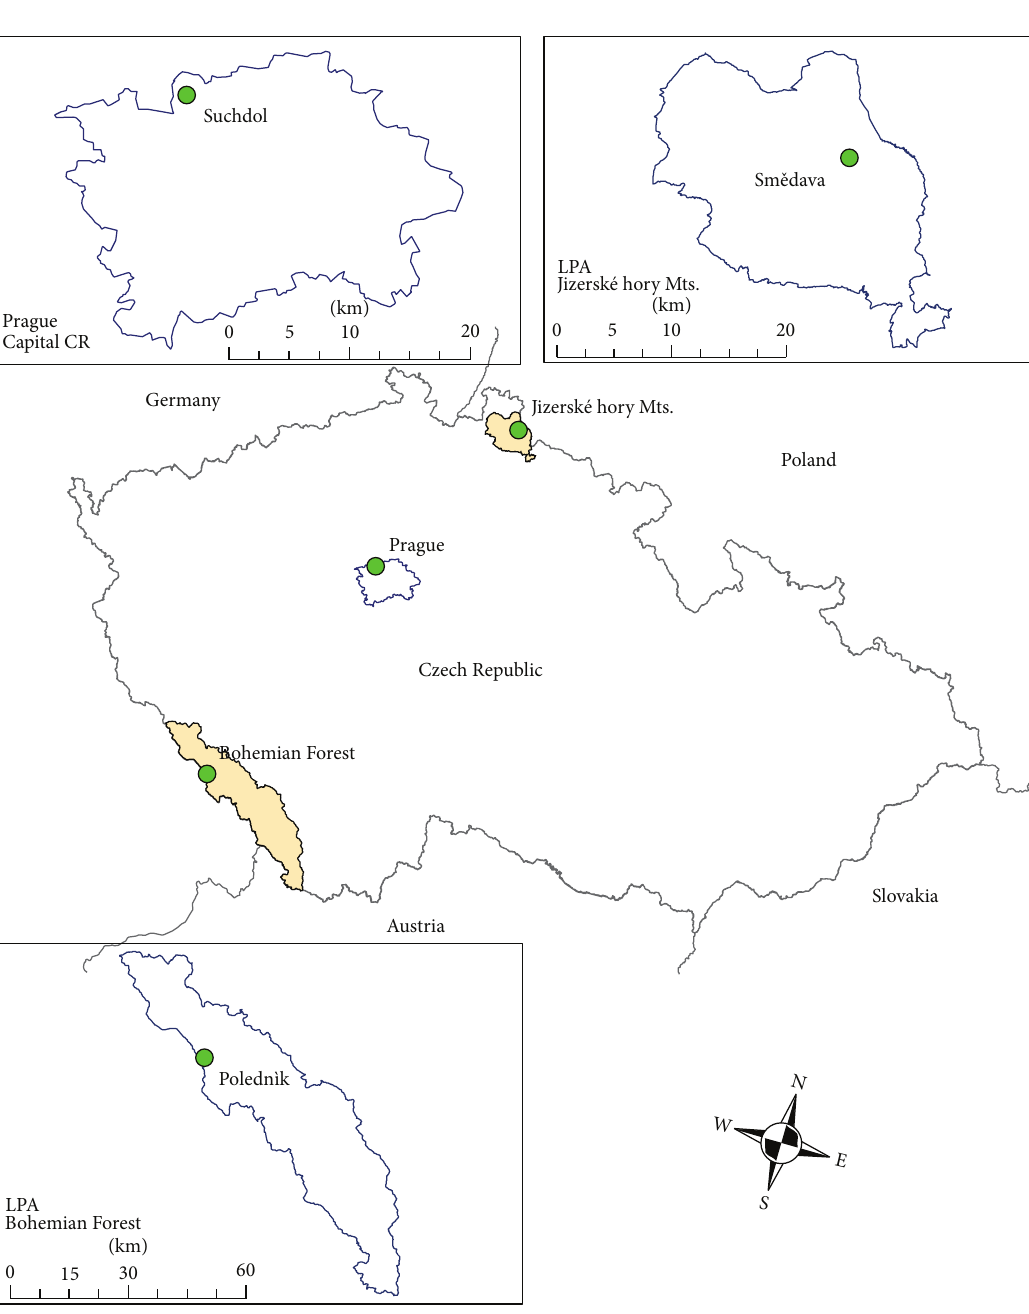
Figure 2: Localization of the experimental stands in the Czech Republic, Suchdol, Prague (capital of the Czech Republic), Smˇedava, Jizersk´e hory Mts. (Landscape Protected Area of the Jizersk´e hory Mts.), and Poledn´ık, Bohemian Forest (Landscape Protected Area and National Park of the ˇSumava